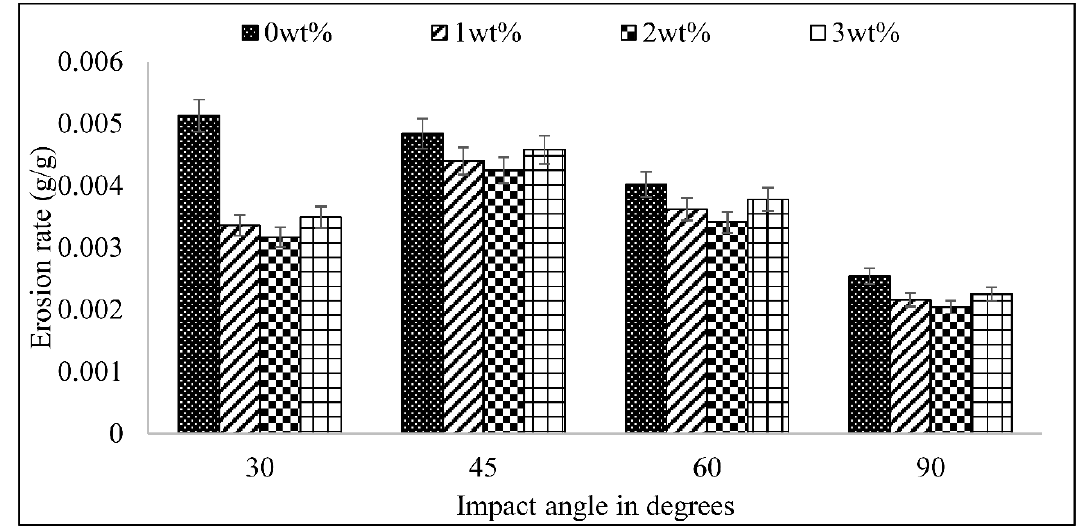
Figure 4. Erosion rate of epoxy resin filled with various WC weight fractions, for different impact angles